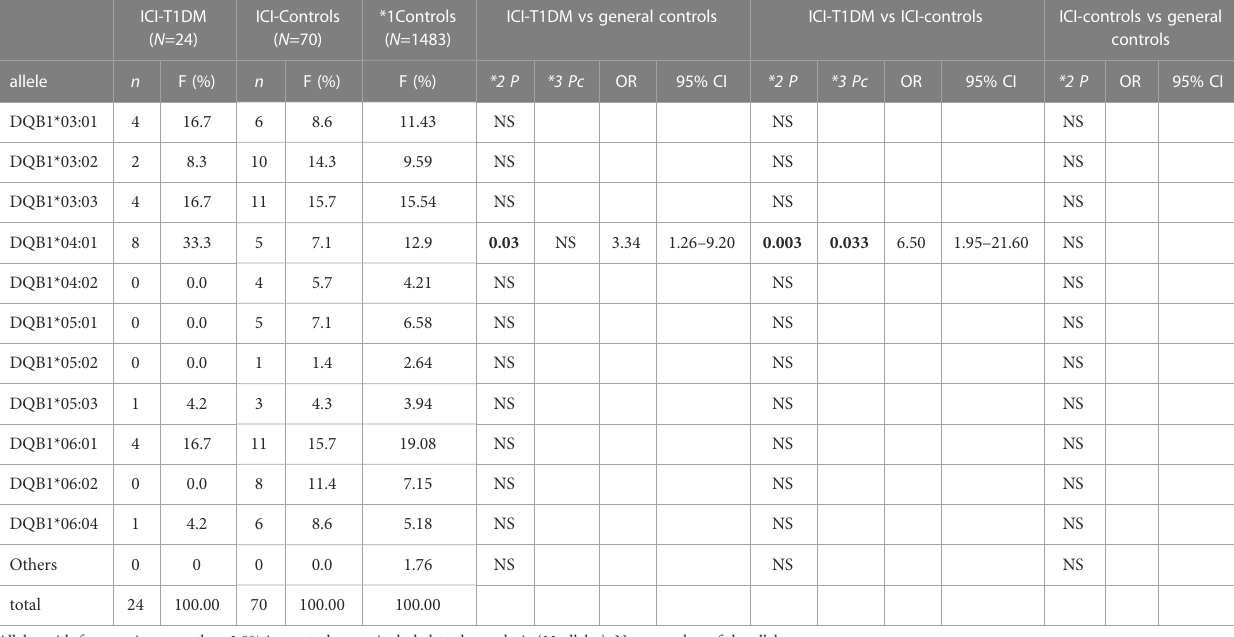
TABLE 2B Allele frequencies of HLA-DQB1 in patients with ICI-T1DM and controls.